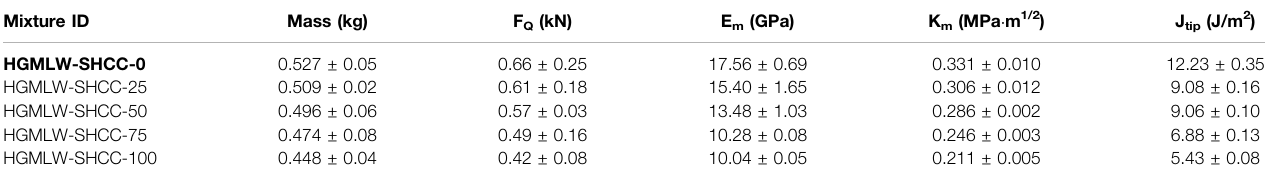
TABLE 4 | Fracture toughness of HGMLW-SHCC. Mixture ID